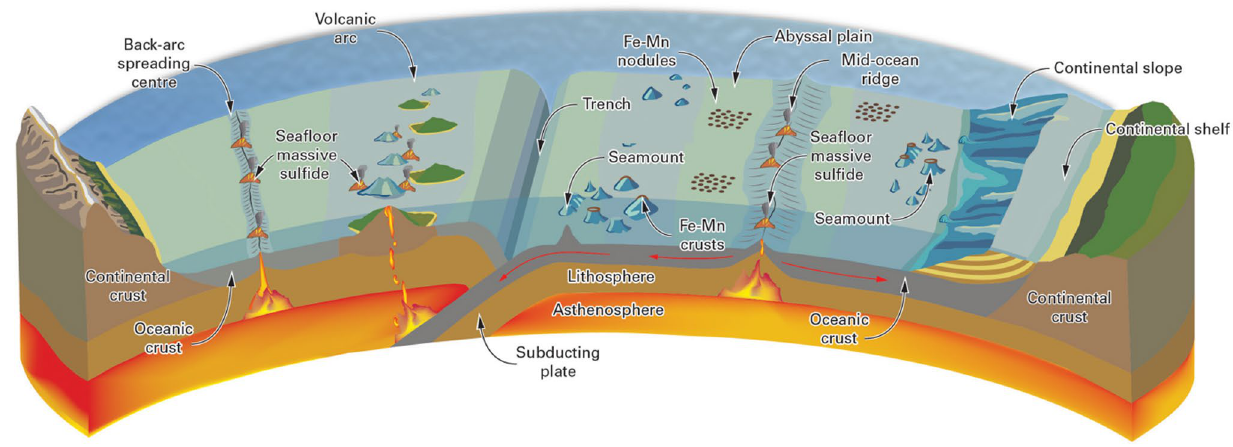
Fig. 17 Comparison of geological conditions of different deposit areas of deep seabed minerals (modified from Lusty and Murton